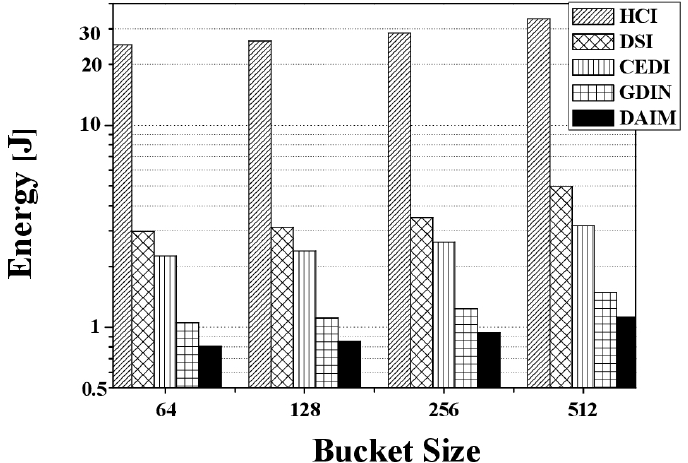
Figure 18. The comparison of the energy consumption over various bucket